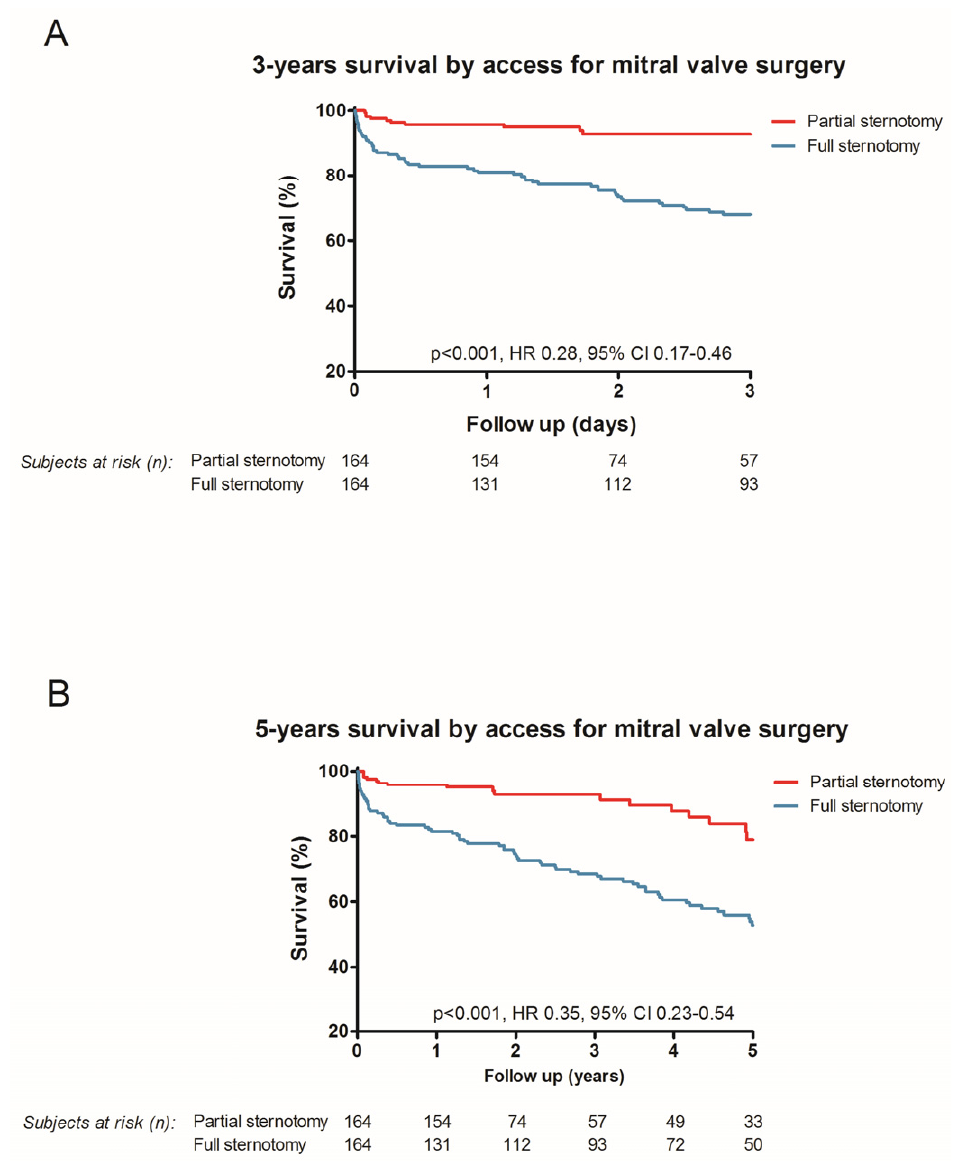
Figure 3. Kaplan–Meier curves for three years ( A ) and five years ( B ).